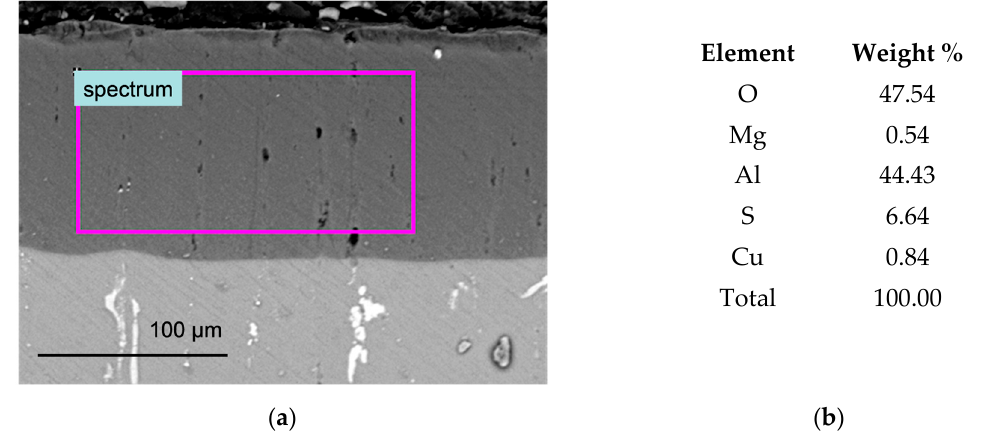
Figure 7. ( a ) Micrograph of an anodized layer synthesized on the surface of aluminum alloy 1011 at an electrolyte temperature of − 4–0 °C for 1 h with a highlighted area for micro-X-ray spectral analysis and ( b ) the results of the analysis of the content of elements in this zone.